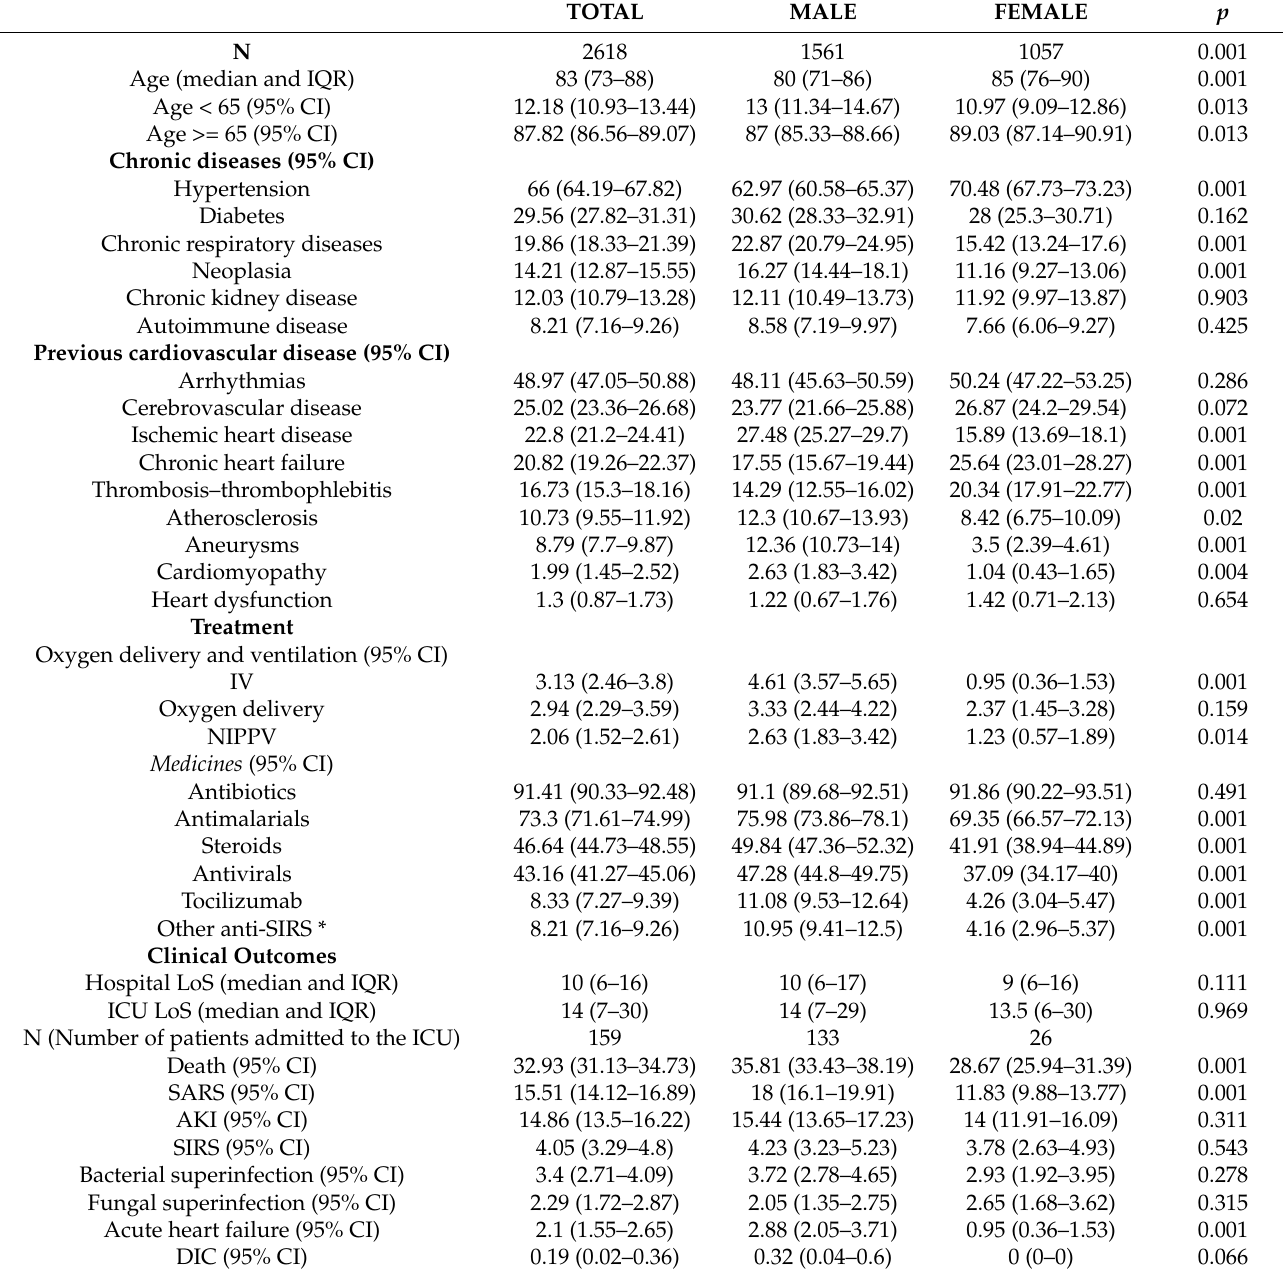
Table 1. Baseline characteristics and clinical outcomes of hospitalized COVID-19 patients with previous